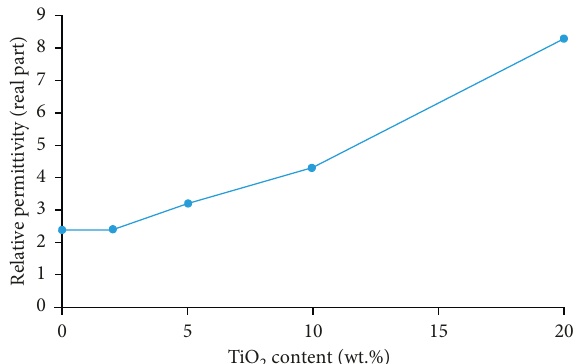
Figure 4: Effect of filler concentration on the real part of relative permittivity.